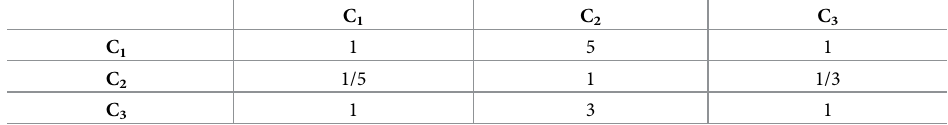
Table 15. Pair-wise comparisons of the first level factors in the emergency response 3.